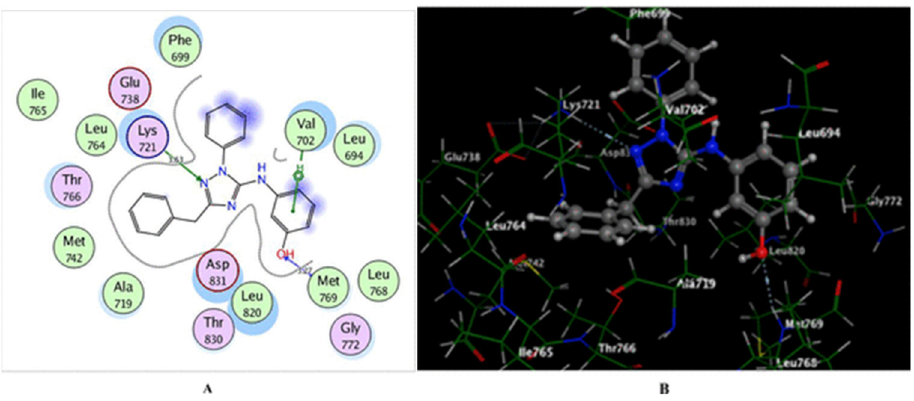
Figure 13. A 2D and 3D schematic of binding interactions ( A , B ) of 6b into